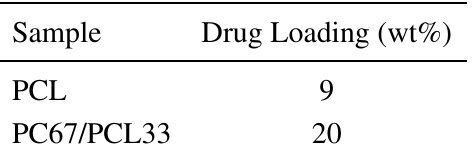
Table 8. Drug loading after impregnation.